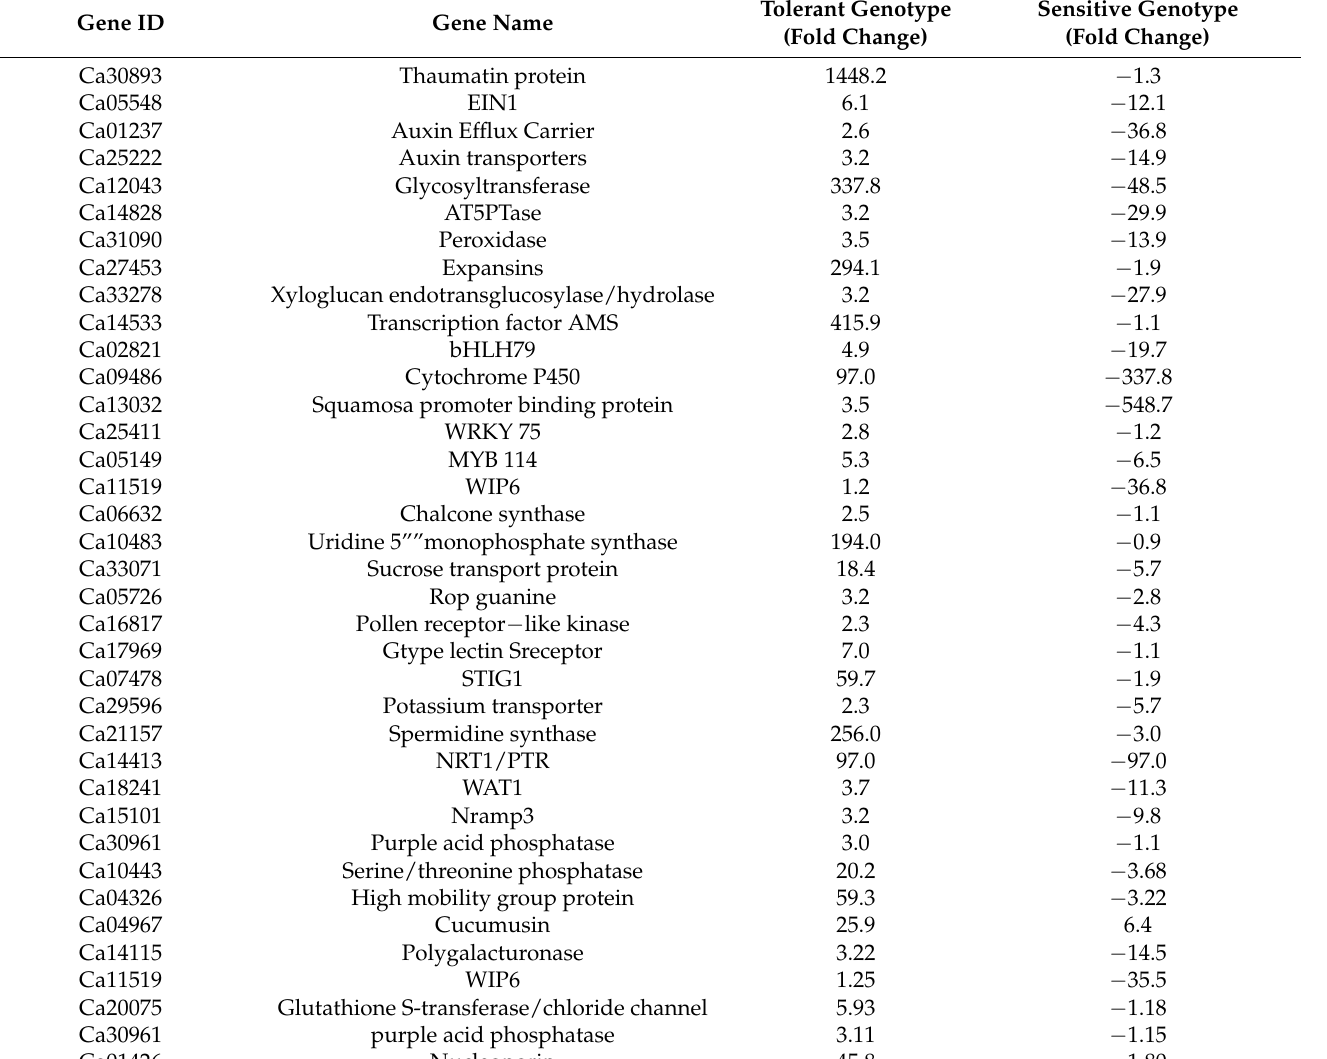
Table 1. List of the important differentially expressed genes in flowers of the tolerant and the sensitive genotype in response to the salt